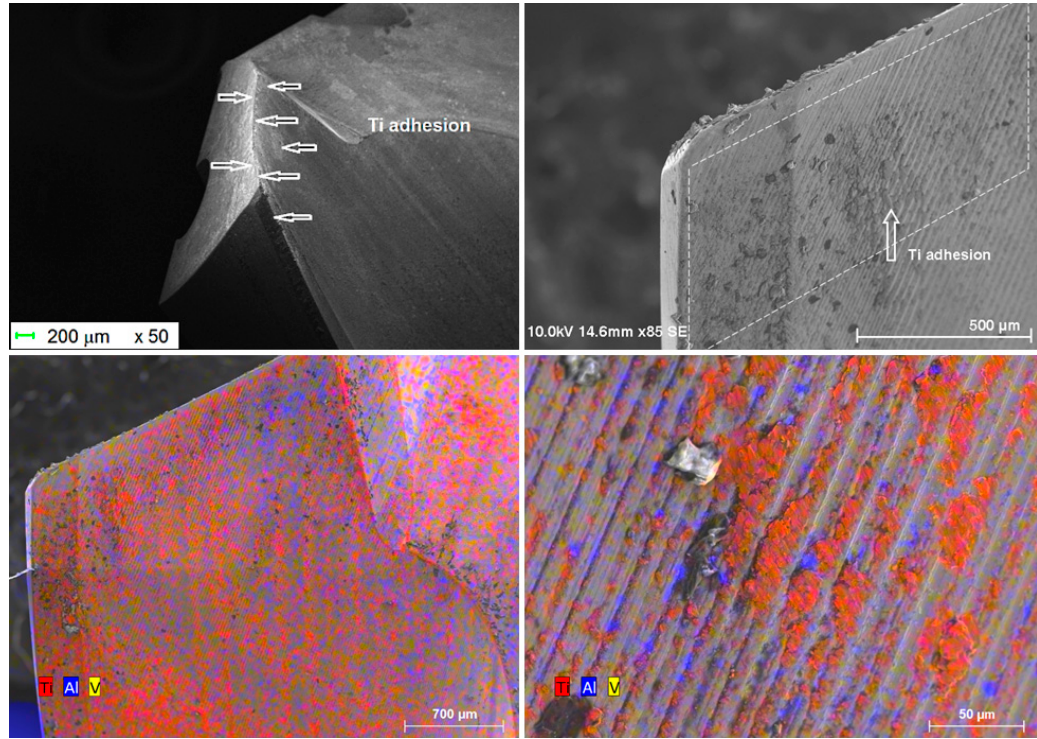
Figure 13. Drill aspect after 25 holes in Ti-6%Al-4%V alone.